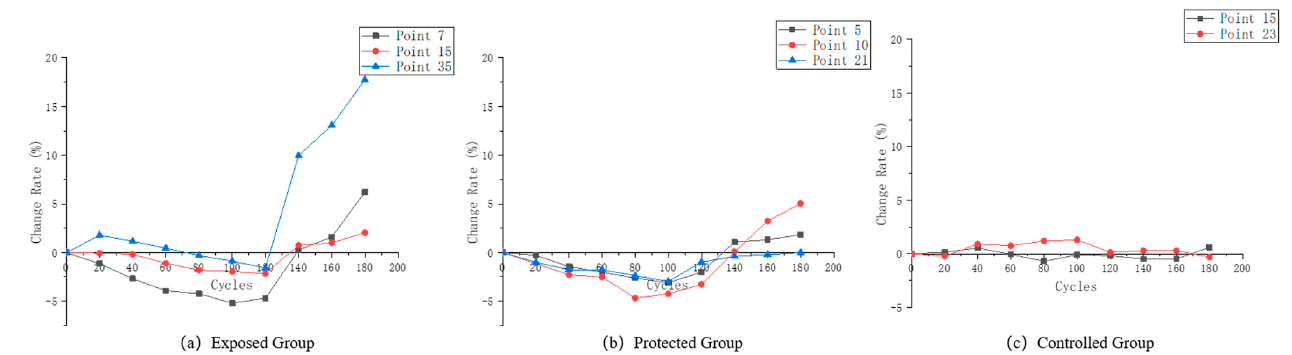
Figure 7. ( a ) Wave velocity variation rate of the characteristic measurement points of the exposed group; ( b ) Wave velocity variation rate of the characteristic measurement points of the protected group; ( c ) Wave velocity variation rate of the characteristic measurement points of the controlled group.